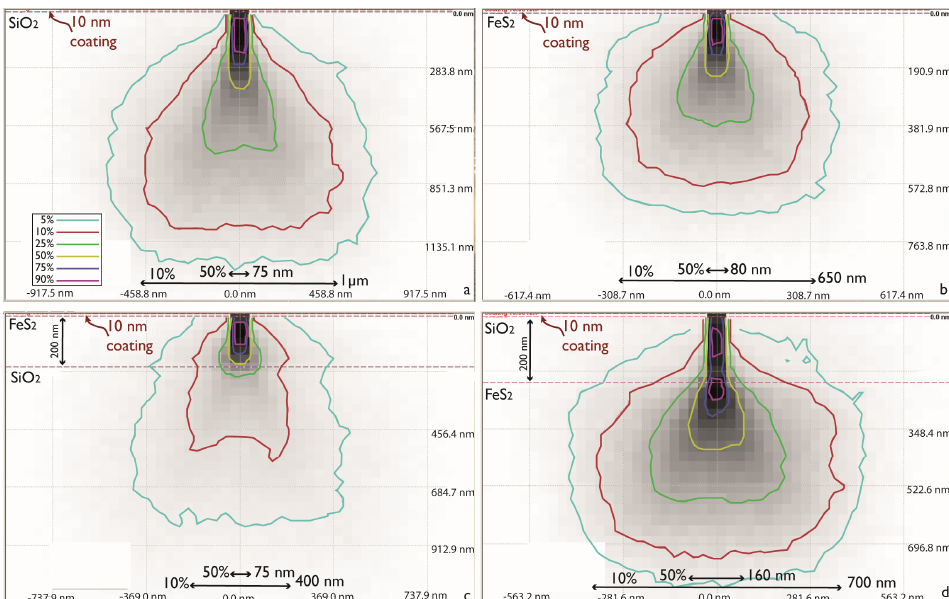
Figure 3. Monte Carlo simulations for the trajectories of 20,000 electrons in quartz (SiO 2 ) and pyrite (FeS 2 ) in carbon ‐ coated samples. Arrows show the width of the interaction volume at 10 kV for 50% and 90% of the electrons. ( a ) Quartz, ( b ) pyrite, ( c ) 200 ‐ nm pyrite on top of quartz, ( d ) 200 ‐ nm quartz on top of pyrite. Simulations were made with Casino [18,19].